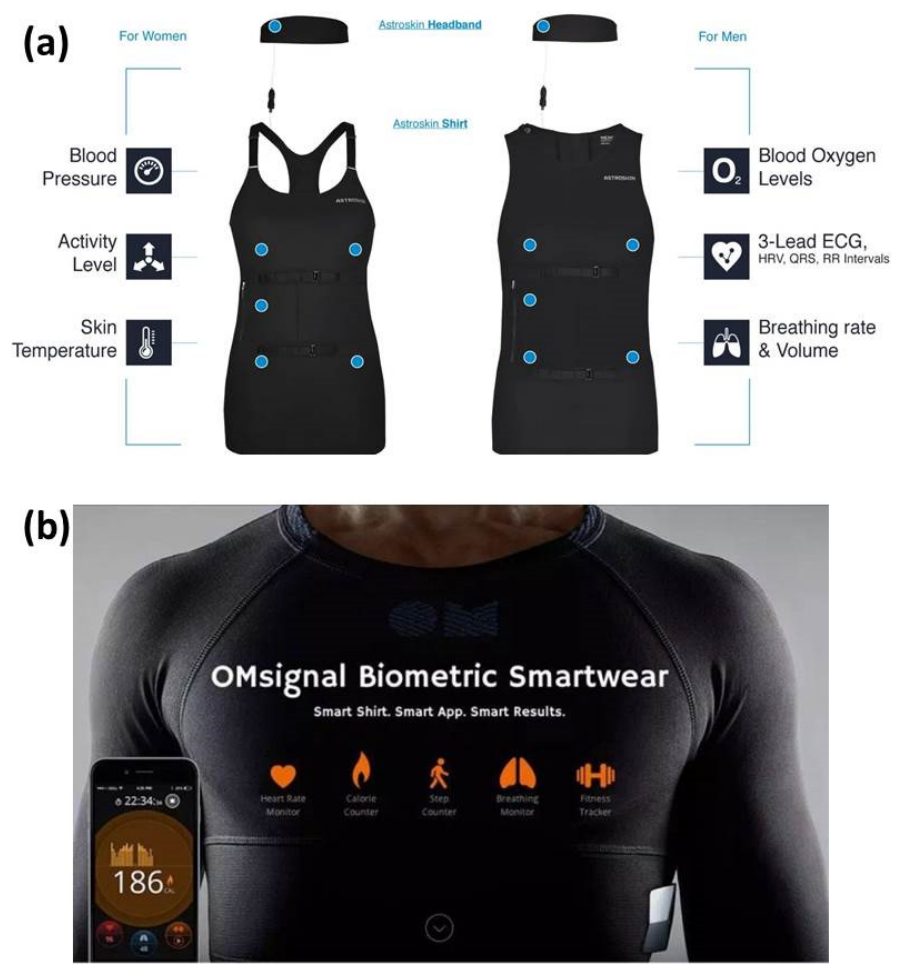
Figure 3. ( a ) An integrated biosensor in the exercise shirt. ( b ) The smart T-shirt with a built-in sensor [68,69]. sensor